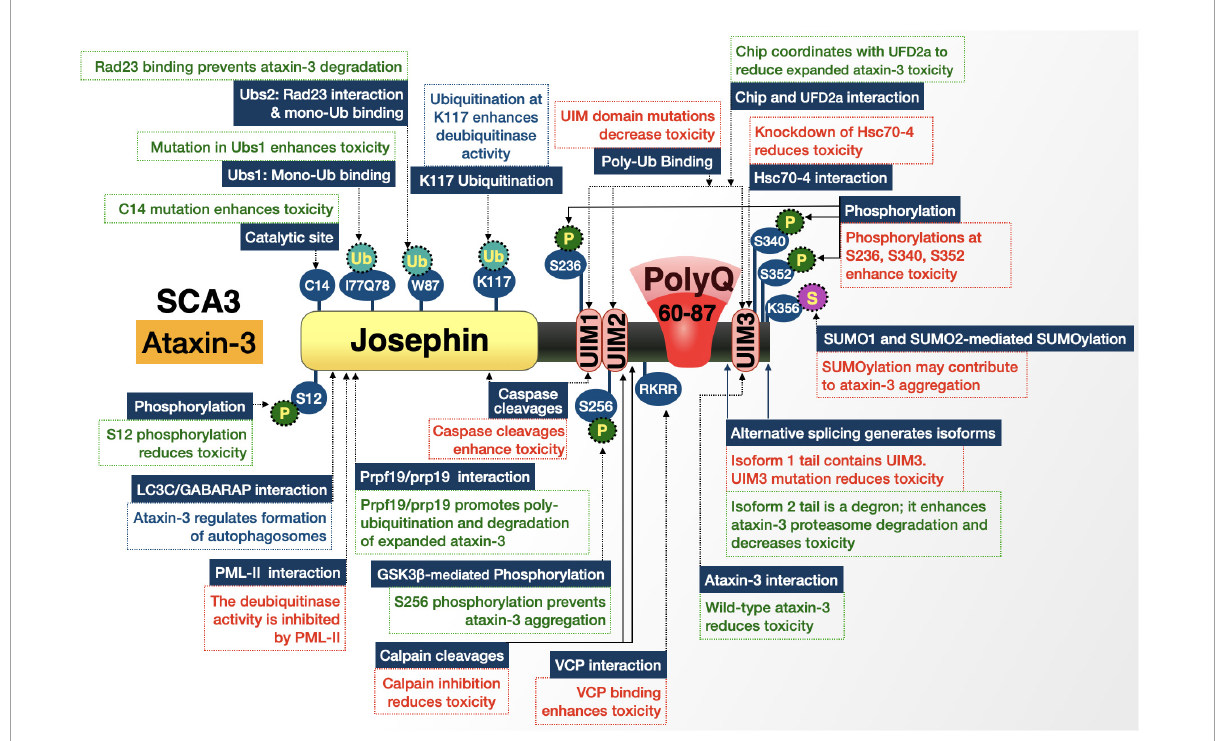
FIGURE7 Graphic representation of the SCA3 protein, its domains, interactions, and modifications. Details are in the main